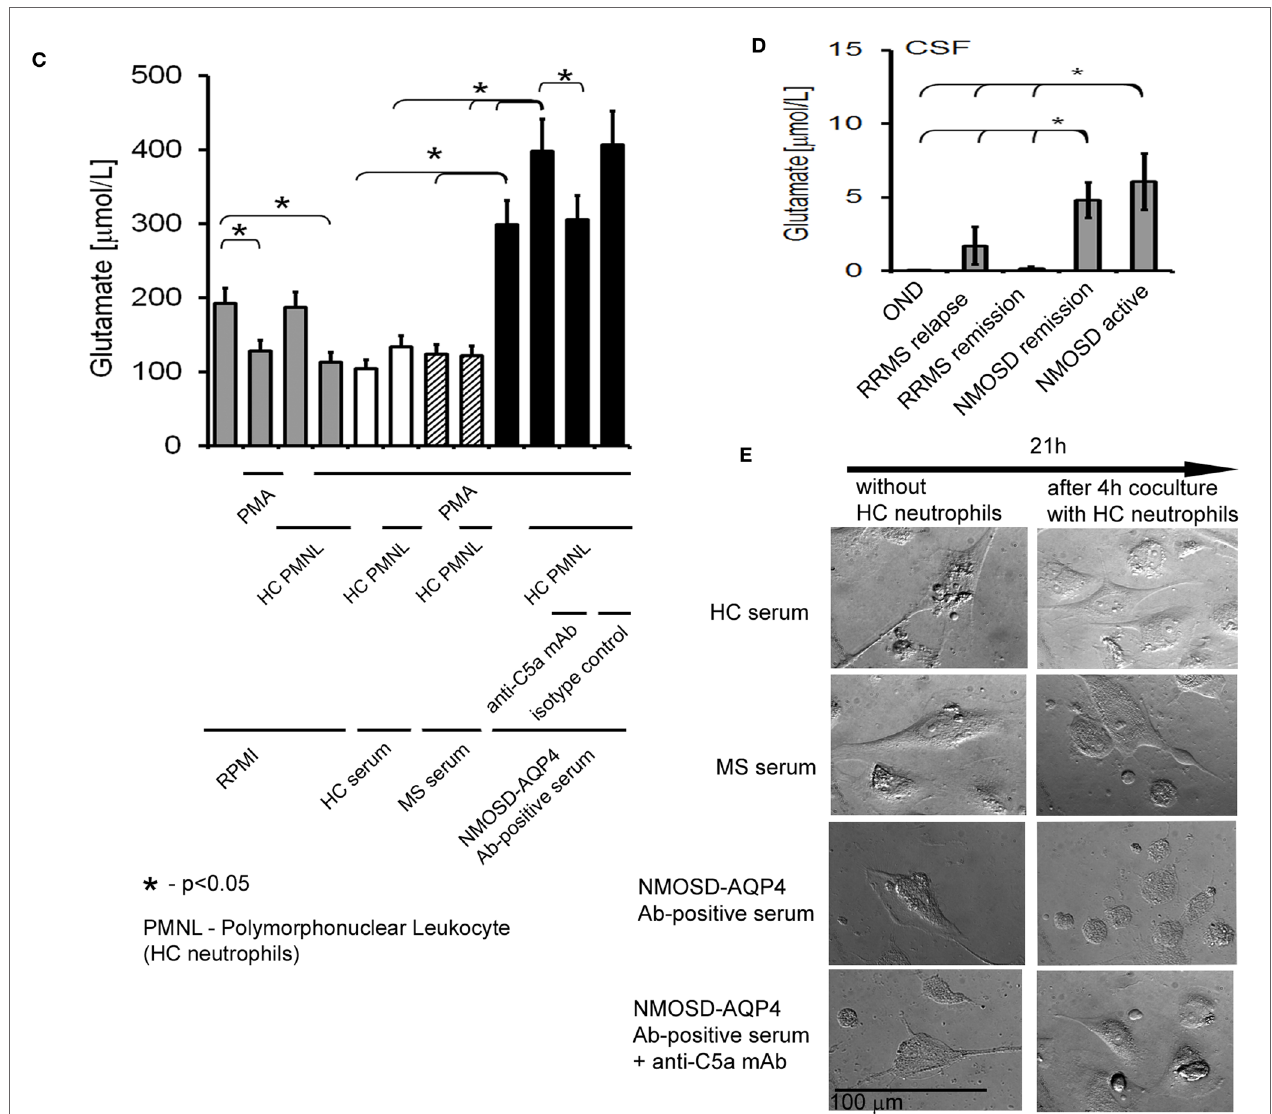
FigUre 5 | Preactivated healthy control (HC) neutrophils polarize astrocytes into proinflammatory cells and enhance glutamate pump dysregulation. (a) An in vitro model of neuromyelitis optica spectrum disorder (NMOSD) inflammation consisting of NMOSD serum, human astrocytes, and HC neutrophils. As controls, multiple sclerosis (MS) serum, HC serum, and astrocytes without serum were used. (b) Human astrocytes produce proinflammatory cytokines and chemokines after incubation with NMOSD serum (left panel), and anti-aquaporin-4 (AQP4) Ab binding astrocytes trigger C5a-induced neutrophil recruitment which subsequently enhances proinflammatory cytokine production by astrocytes (right panel). (c) Anti-AQP4 Ab-positive serum in cooperation with HC neutrophils destabilizes astrocytes and reverses glutamate pump resulting in high glutamate concentration in extracellular space. (D) Cerebrospinal fluid (CSF) from NMOSD patients both in the active and remission stages contains higher concentration of glutamate, compared with remitting–relapsing multiple sclerosis (RRMS) or other neurological disorders (OND). (e) Anti-AQP4 Ab-positive serum in cooperation with HC neutrophils interrupts active transport of H 2 O by aquaporin-4 (AQP4) channel in astrocytes. DIC microscopy analysis reveals reduction of astrocyte volume and disruption of their shape. Images were acquired using Zeiss Axiovert 200 inverse microscope with a Zeiss Plan-apochromat 63 × /1.43 differential interference contrast objective after 21 h